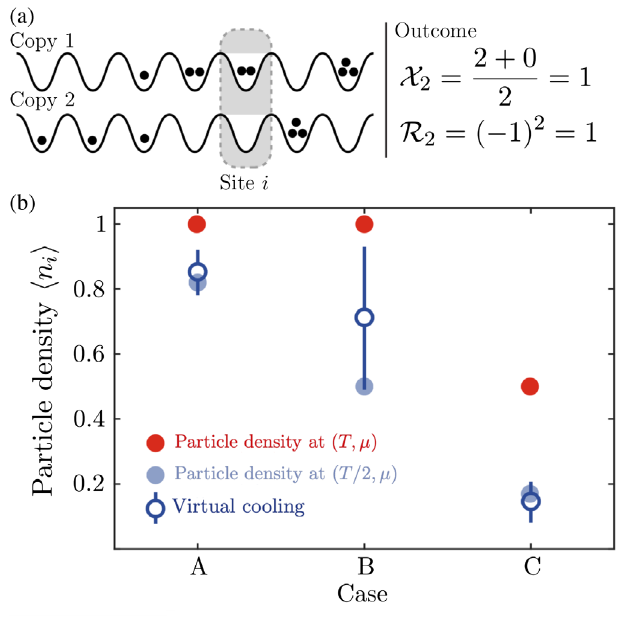
FIG. 2. (a) Schematic for a single measurement trial of X 2 ¼ 1 n n R i th site, after F 1 ;i þ 2 ;i Þ and 2 restricted to the 2 has been 2 ð applied to the two copies. (b) Measured single-site density, averaged over all but the edge sites of the chain, after virtual cooling has been applied to the system (blue circles with vertical error bars). Red disks show the single-site density of the state before our protocols are utilized (the actual density of particles in each experiment), whereas light blue disks correspond to the prediction of the effective thermal ensemble (see text) at half the temperature. Agreement of the data with the reduced-temperature ensemble validates the applicability of our method in the experimental system. Error bars denote the standard error of the